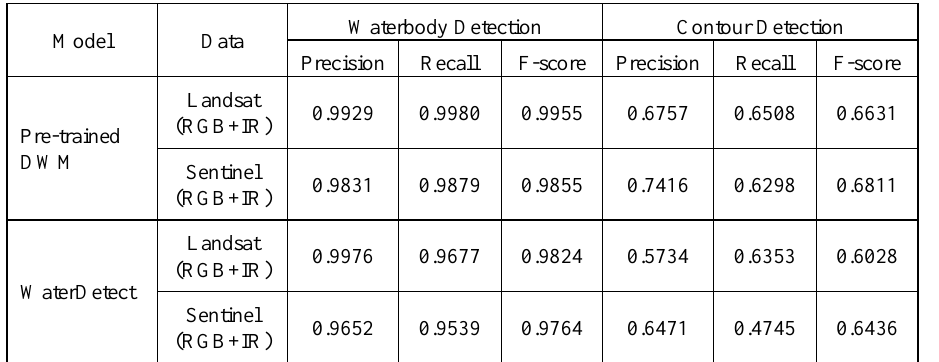
Table 1. Contour detection as a function of waterbody detection.